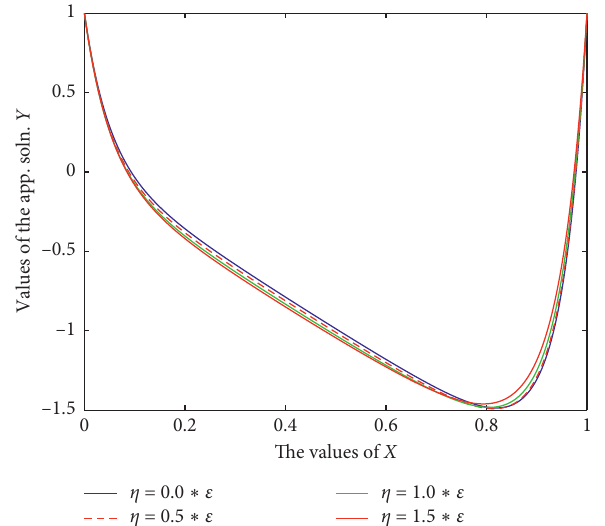
Figure 3: Plot of the solutions of Example 2 for ε � 0.1 and N �